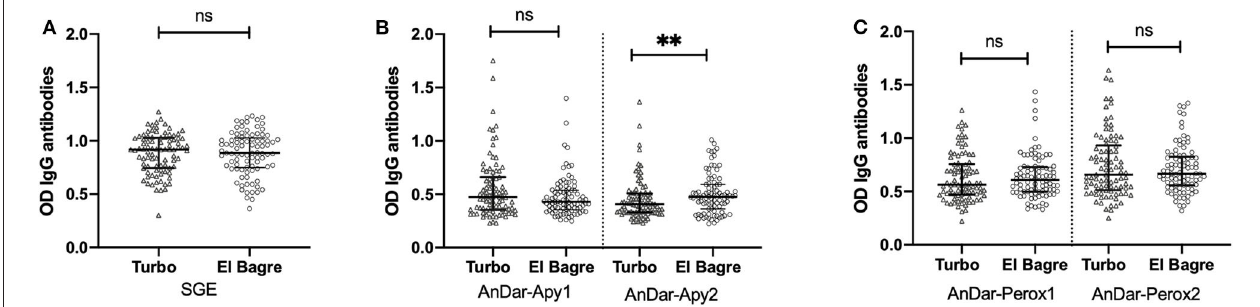
FIGURE 2 | Comparison of IgG antibody levels against An. darlingi SGA (A) and peptides from Apyrase (B) and Peroxidase (C) between the study sites (Turbo and El Bagre). ns denotes not significant, p < 0.05 (* = 0.01 to 0.05, ** = 0.001 to 0.01, and *** = 0.0001 to 0.001).